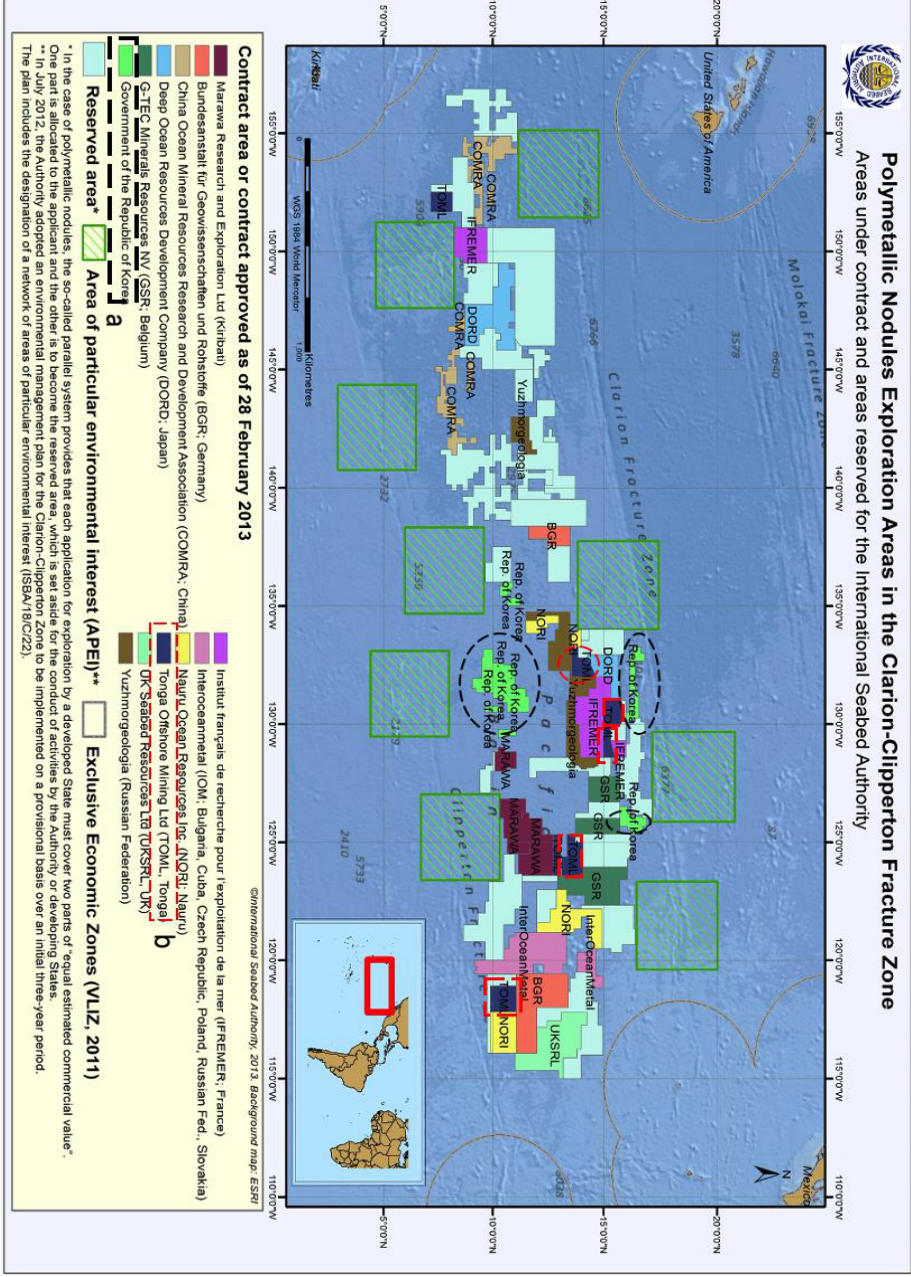
Figure 1. The two chosen study cases shown in the map: ( a ) Nautilus Minerals-Tonga Offshore Mining Ltd. (TOML, Maufanga, Tonga). DeepGreen (Vancouver, Canada) gets the rights of the polymetallic nodule exploration contract awarded by the International Seabed Authority (ISA) (Kingston, Jamaica) which was initially awarded to TOML; ( b ) The S.Korean Government exploration licence was granted on the CCZ in the late 2000 [5].